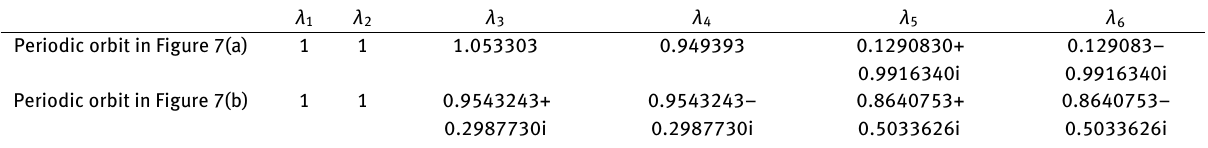
Table 5. Characteristic multipliers of periodic